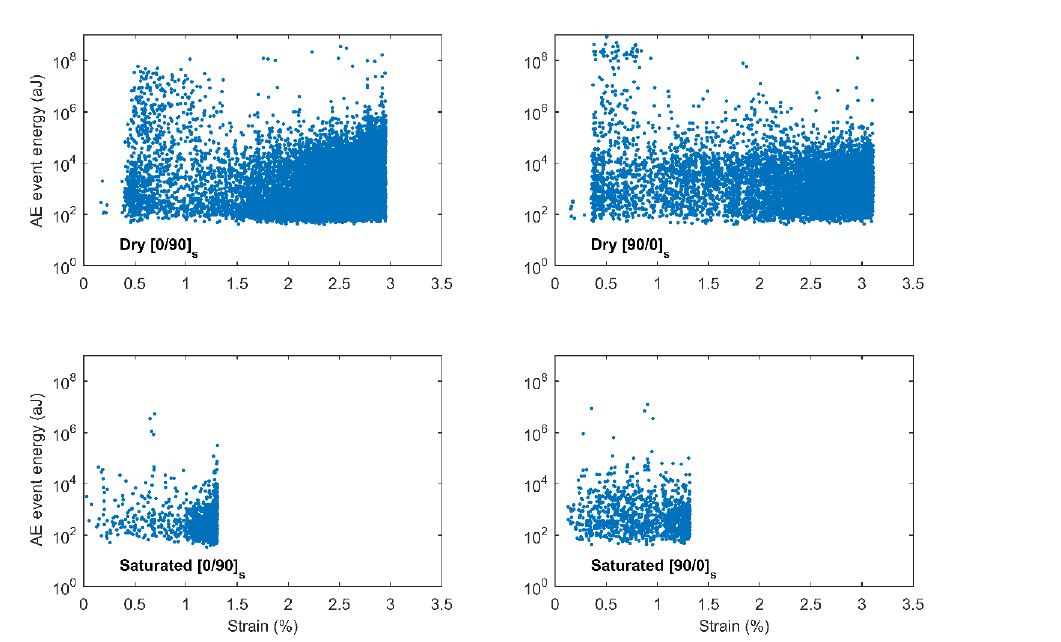
Figure 14. Typical event energy versus strain for four-ply